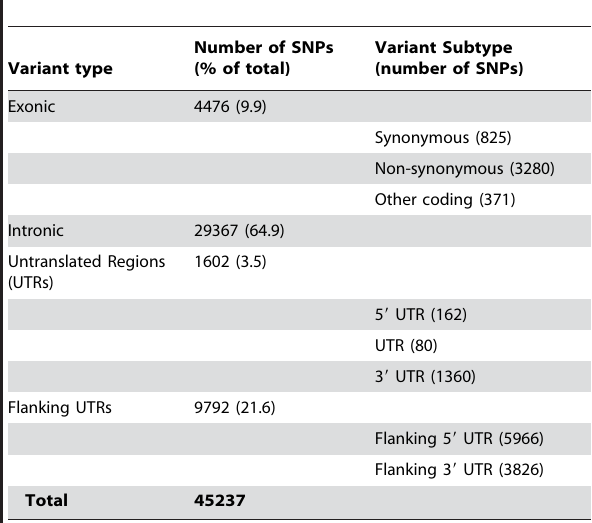
Table 1. Genetic variant types assayed on